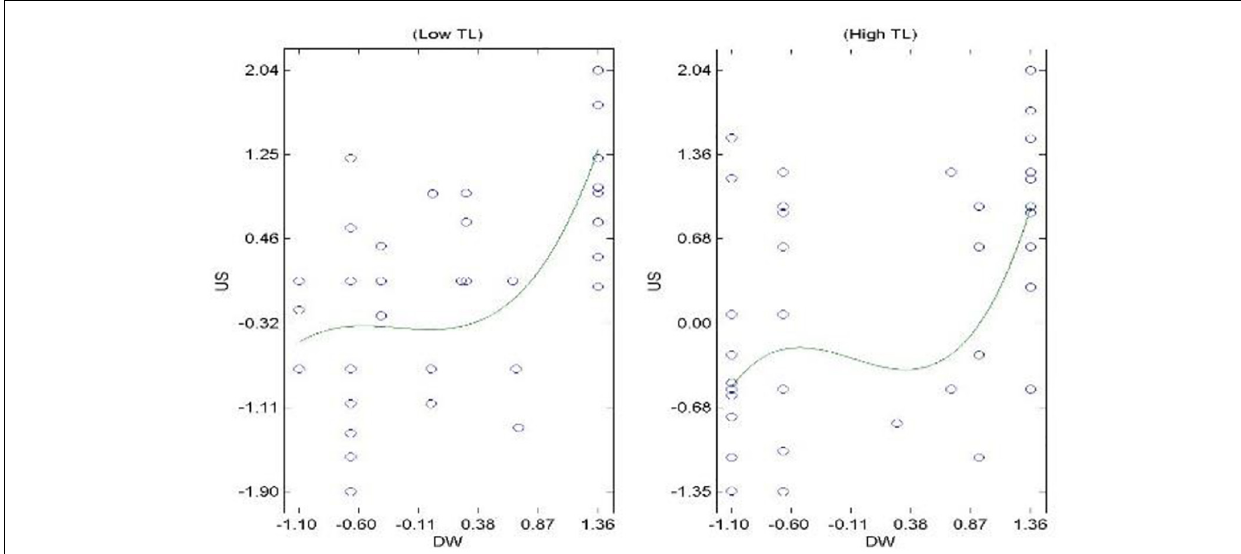
FIGURE 1 | Moderation of TL on the relationship of COV-DS and JUSS.